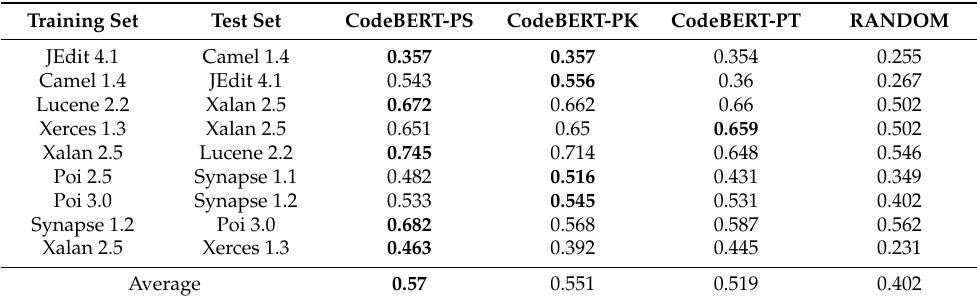
Table 6. Performance comparison of CodeBERT-PS, CodeBERT-PK, CodeBERT-PT, and RANDOM models on the CPPSC dataset for cross-project defect prediction. The float values are the average F-measure values. The best F-measure values are highlighted in bold. Training